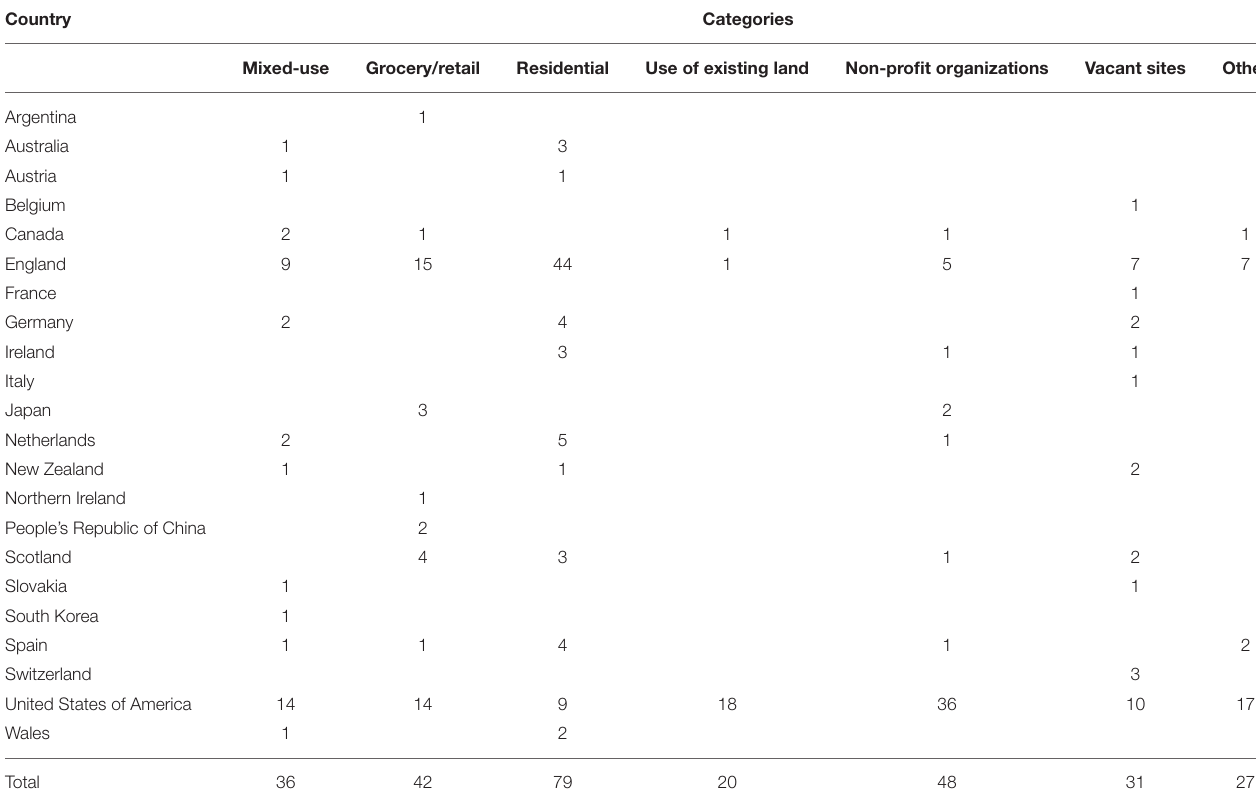
TABLE 1 | Redevelopment trends in shadow